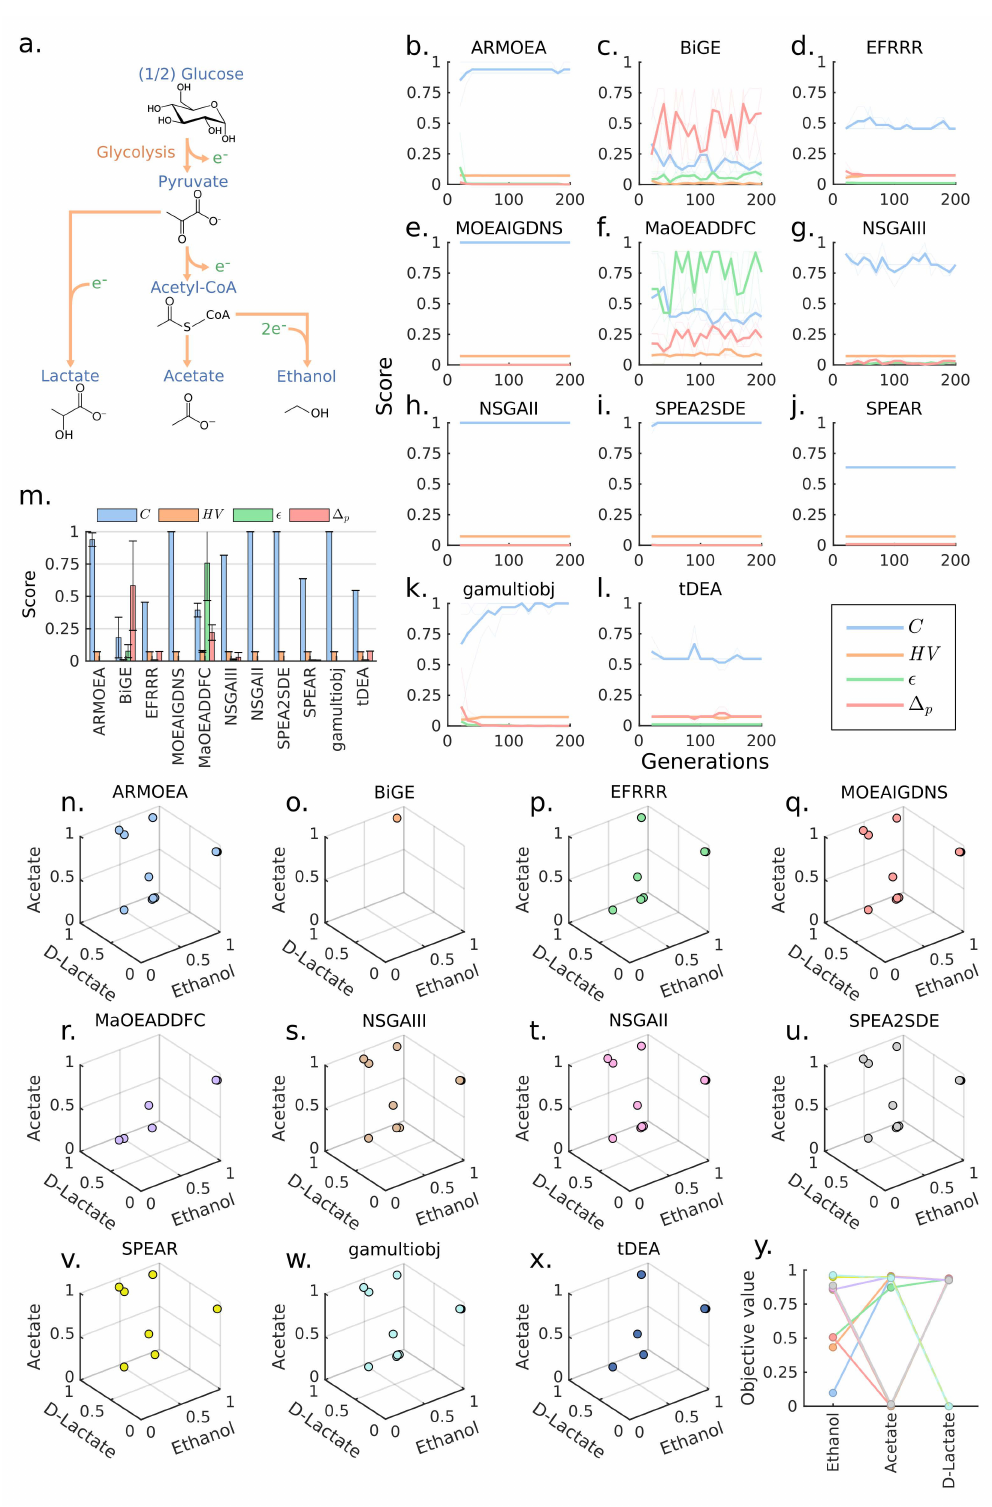
Figure 2. Comparison of MOEAs for a 3-objectives design problem. ( a ) The simplified metabolic pathways for conversion of glucose to the target products. Reducing equivalents are presented with e − . ( b – l ) Generation-dependent performance metrics for various MOEAs. ( m ) Performance metrics for various MOEAs at the last generation. ( n – x ) Pareto fronts of various MOEAs at the last generation. It should be noted that only the first replicate is plotted for clear illustration. ( y ) Reference Pareto front ( PF ∗ ). Each line represents a